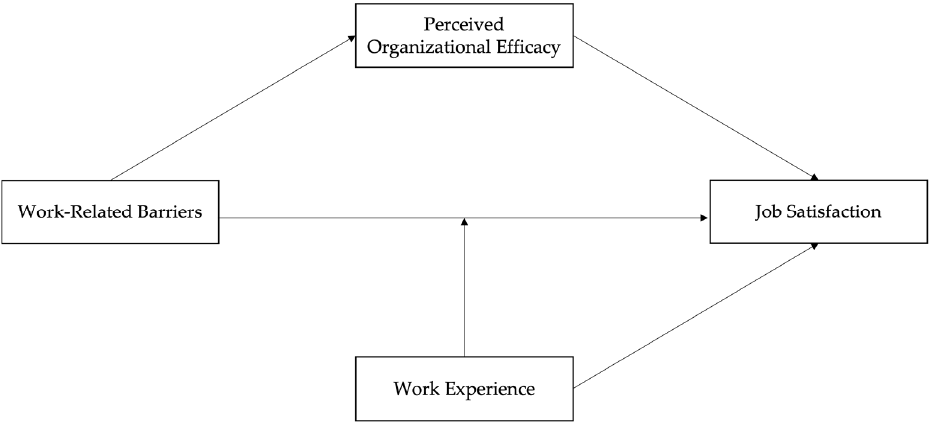
Figure 1. Hypothesized